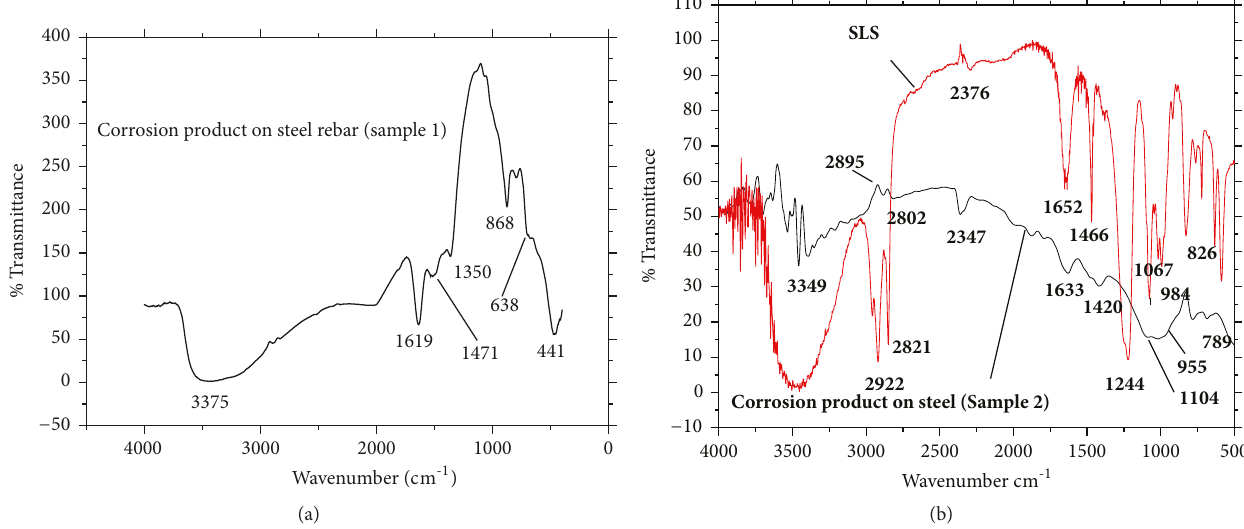
Figure 6: IR spectrum of oxide film deposited on the steel reinforcement in (a) SAMPLE 1 and (b) SAMPLE 2 and spectrum of SLS.